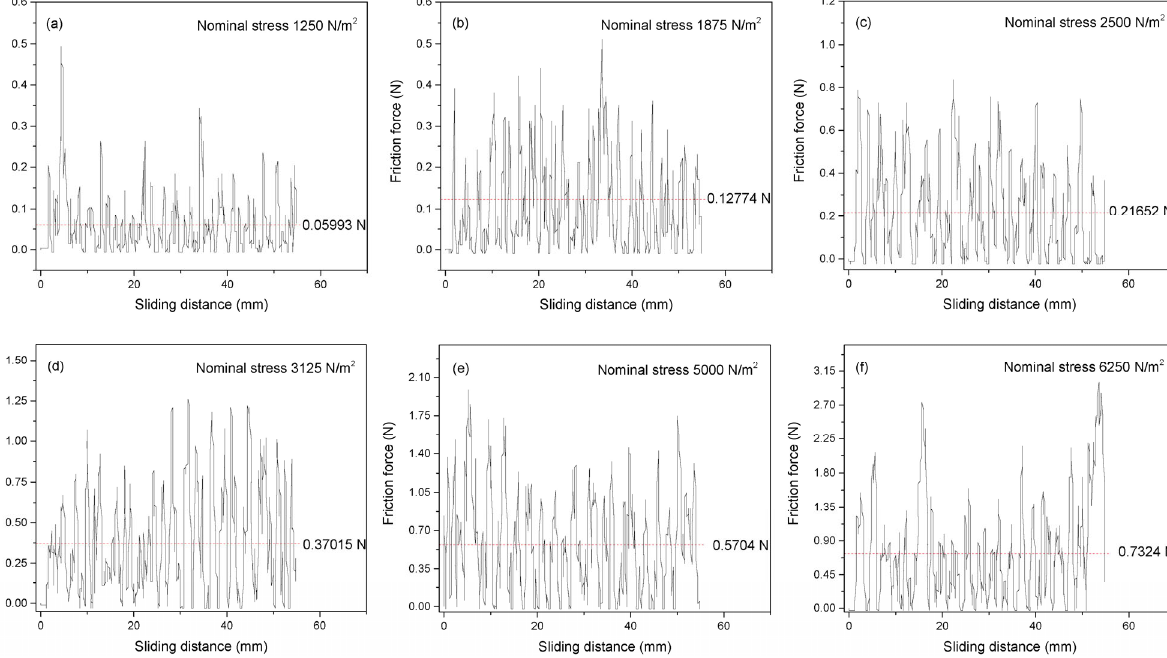
Fig. 8 Variation of friction force with sliding distance of 55 mm under different nominal stress when the area ratio was